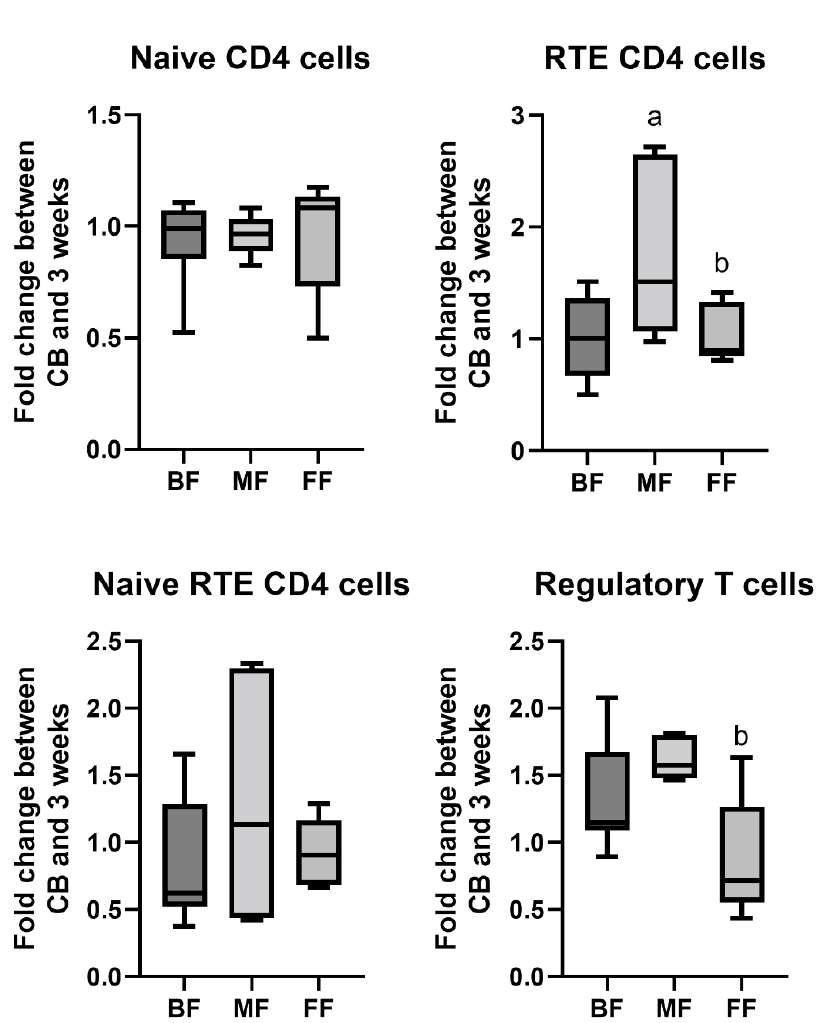
Figure 3. Fold change of the investigated cell subsets in neonates between birth and three weeks of age according to the feeding method (BF — exclusively breastfed ( n = 9), MF — mixed fed ( n = 5), FF — exclusively formula fed ( n = 5)). p < 0.05 vs. a — BF, b — MF. Line — median, box — quartiles, whisk- ers — range.